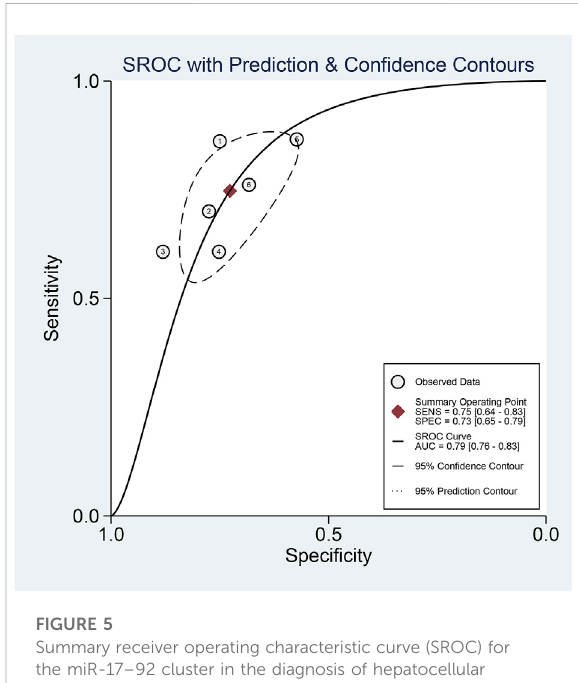
FIGURE 5 Summary receiver operating characteristic curve (SROC) for the miR-17 – 92 cluster in the diagnosis of hepatocellular